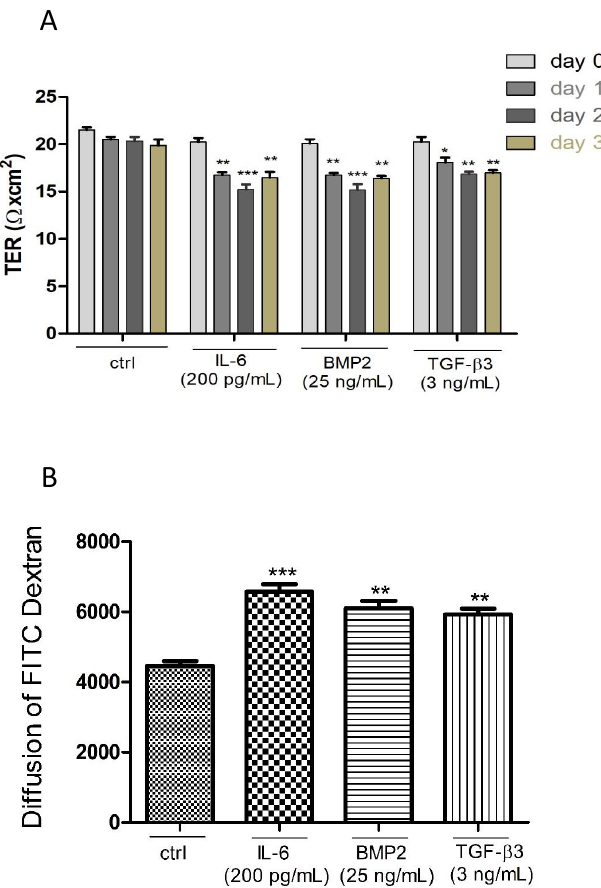
Figure 11. Treating PASC1 with IL-6, BMP2 or TGF- β 3 decreased the TER values time-dependently as compared to the untreated controls (ctrl) ( A ). After the treatment of PASC1 with IL-6, BMP2 or TGF- β 3 for 48 h, a significant increase of diffusion of FITC-dextran was observed. The values are normalized to the control (=100) ( B ). Data points represent the mean values ± SEMs obtained from three independent repetitions performed in duplicates (n = 6); * p ≤ 0.05; ** p < 0.01; *** p < 0.001. OD: Optical